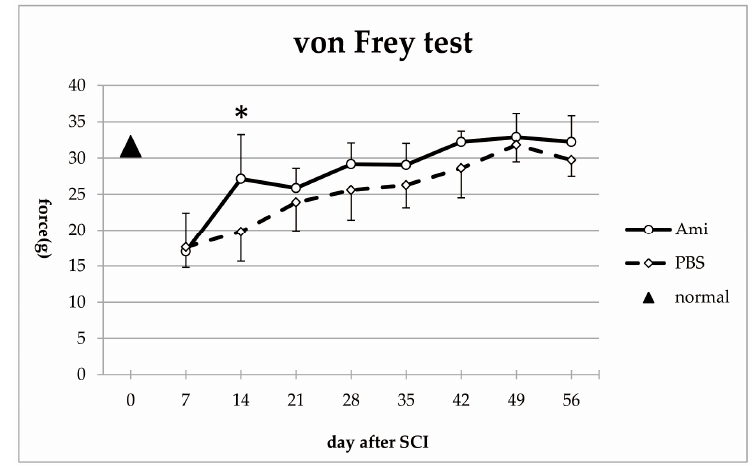
Figure 2. Compared to control rats (triangle, n =5), a sharp drop in the mean force required to elicit a paw withdrawal was observed in both groups after SCI, suggesting the development of allodynia. Amiloride treatment improved sensory function recovery after SCI, with the amiloride group registering a significantly higher force compared with the PBS group at day 14. The asterisk indicates a significant difference between the amiloride group (Ami) and the PBS group (PBS) with two-way repeated measures ANOVA, followed by Tukey’s multiple comparison test (* p < 0.05, n = 5 per group, error bars are standard deviations).